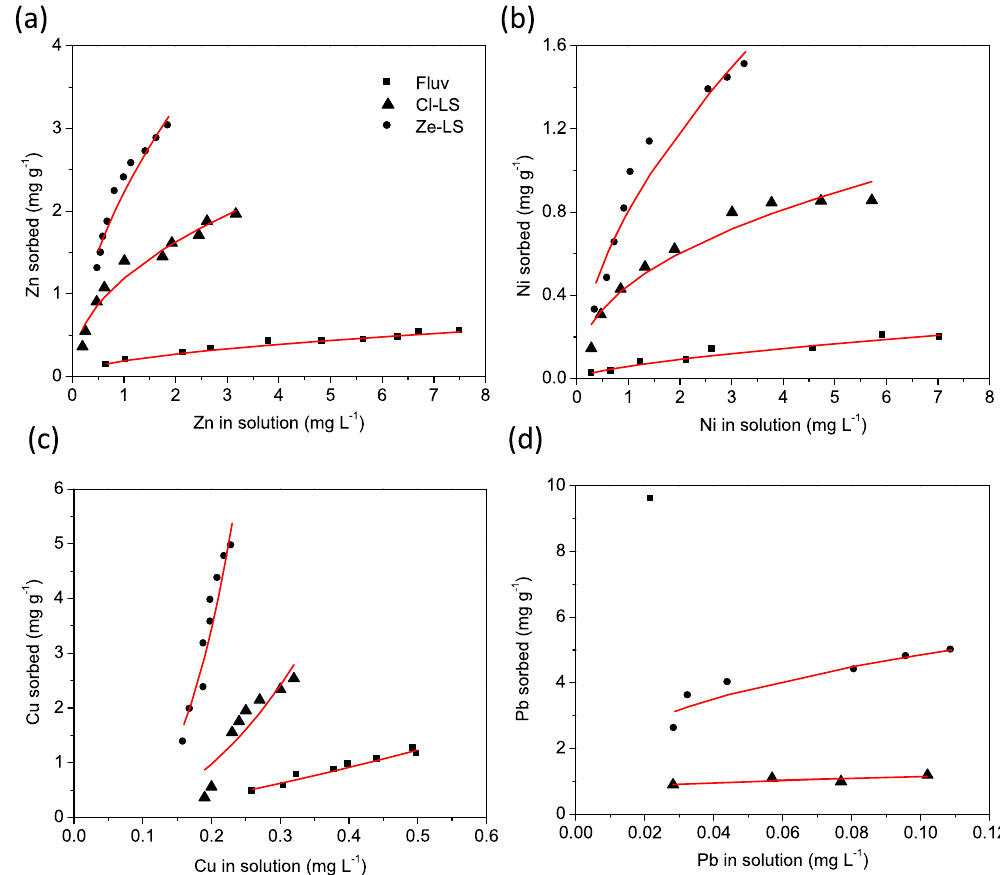
Figure 4. Adsorption isotherms of ( a ) Zn, ( b ) Ni, ( c ) Cu and ( d ) Pb to fluviatile sand (Fluv) and zeolite- (Ze-LS) and clinopyroxene-dominated lava sand (Cl-LS). Red lines show the fitting results using a one-site Langmuir adsorption